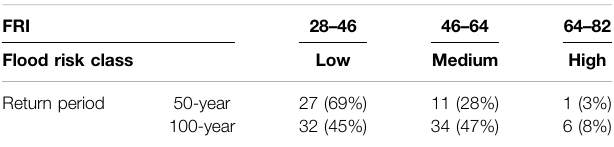
TABLE 13 | Number of buildings in each fl ood risk class.